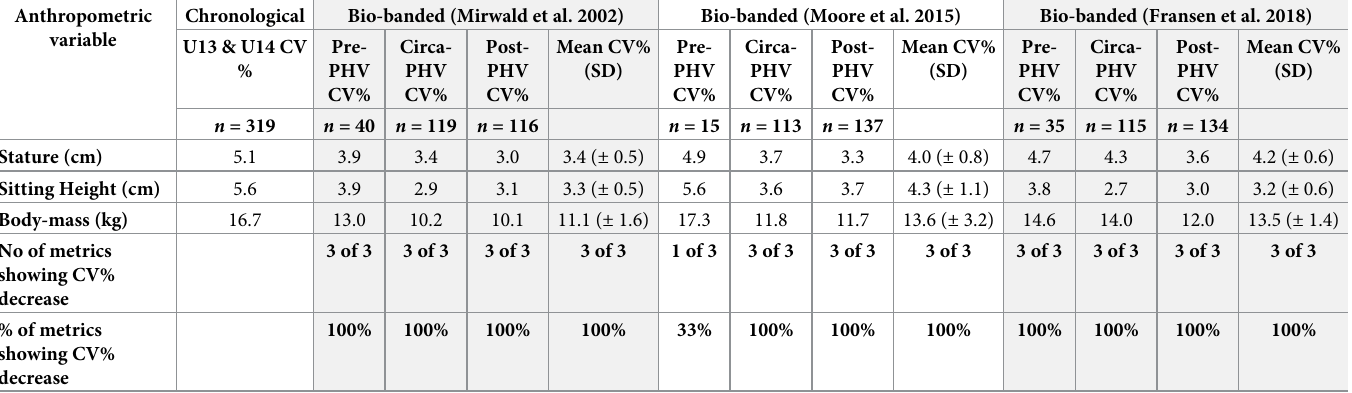
Table 1. Summary table of the coefficient of variance (CV%) for U13 and U14 academy soccer players anthropometric characteristics when categorised using an aggregated chronological age group or three different Mirwald, Baxter-Jones [23], Fransen, Bush [24] and Moore, McKay [29] bio-banding (pre-PHV, circa-PHV and post-PHV)